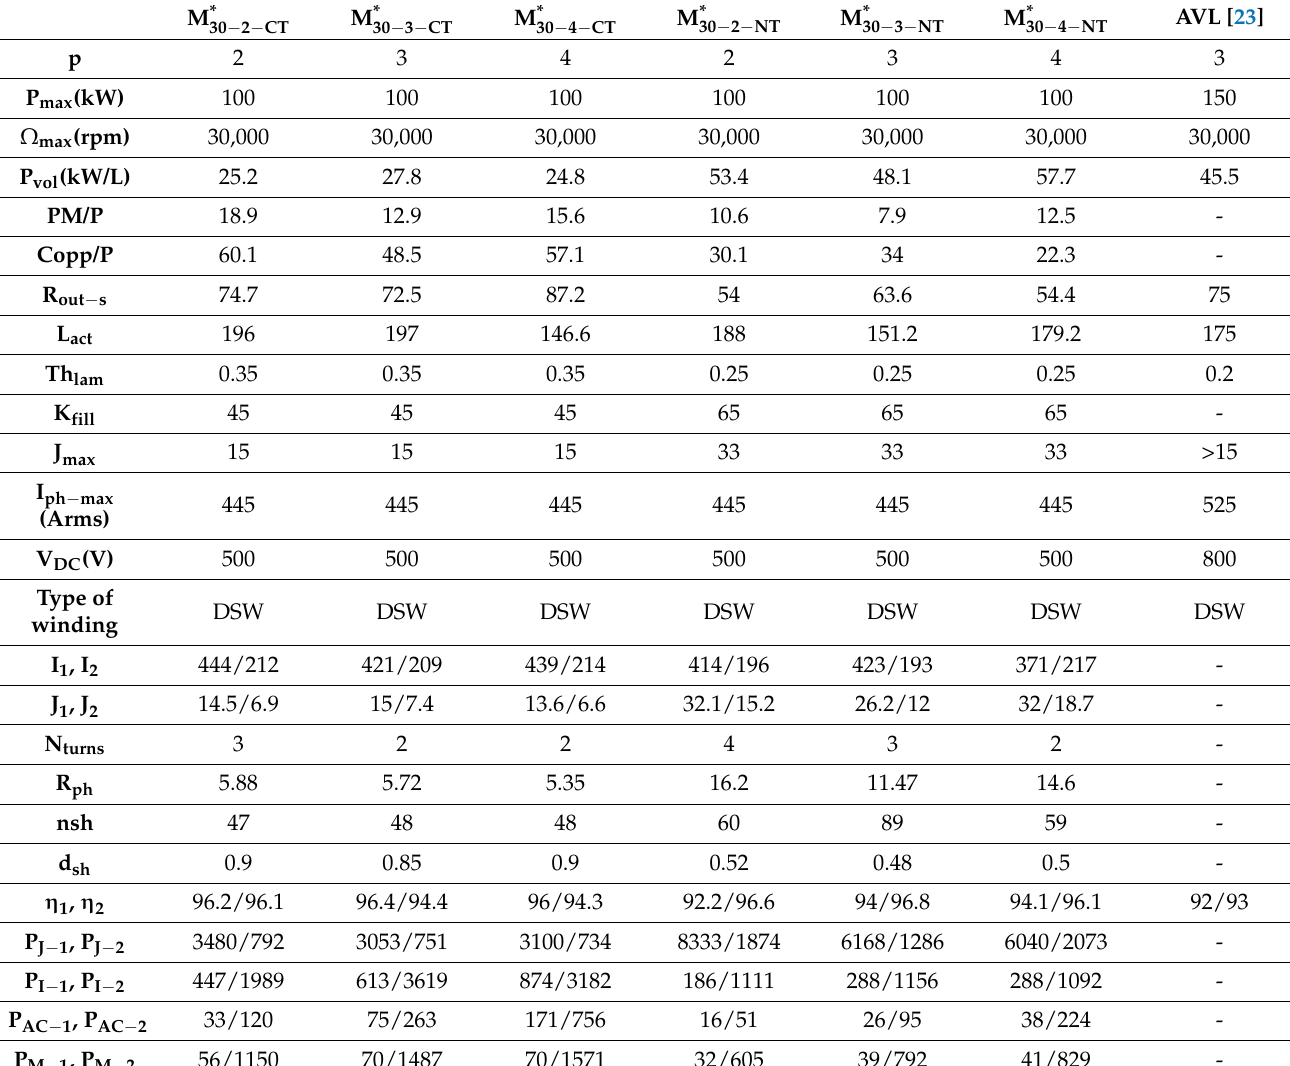
Table 7. Performances and characteristics of optimal machines operating at Ω max = 30,000 rpm and machines designed by AVL